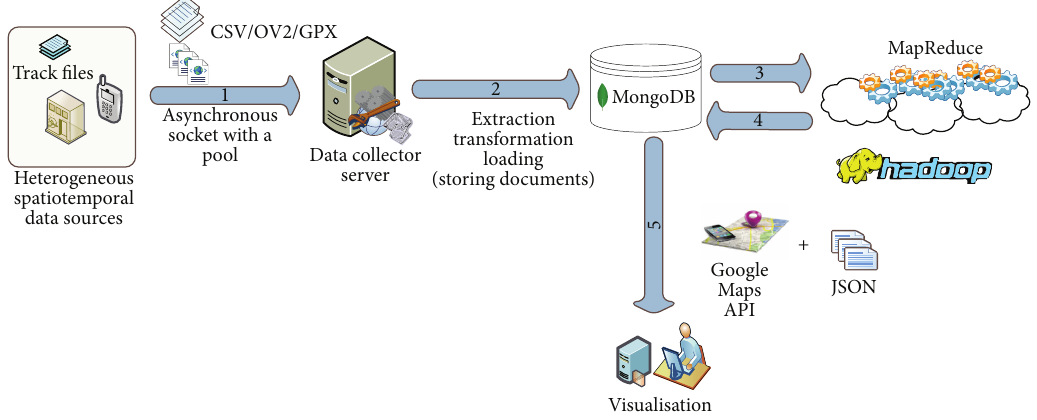
Figure 12: MongoDB-Hadoop